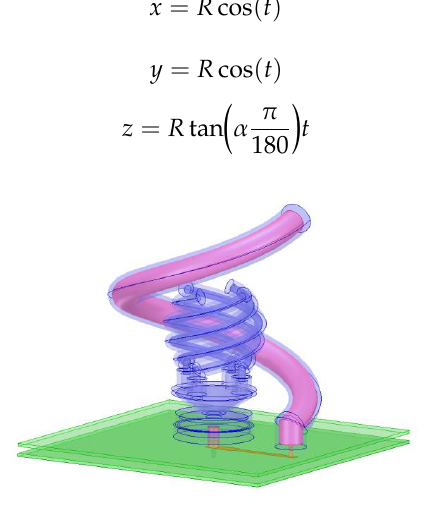
Figure 2. Diagram of State-I with liquid metal filled in.